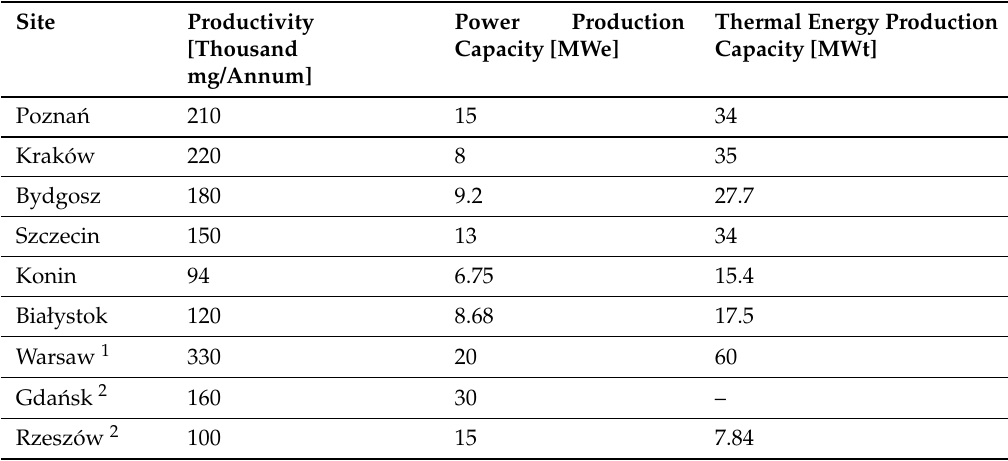
Table 2. Municipal waste incineration installations in Poland, as of October